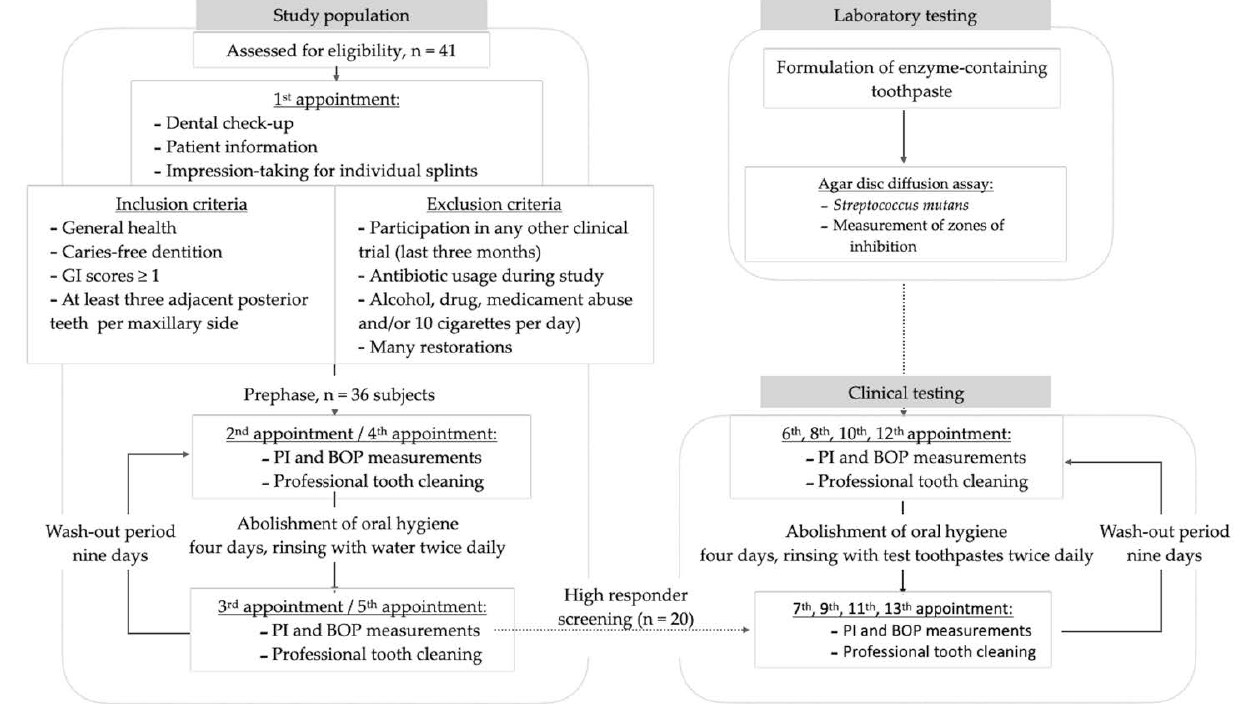
Figure 2. Flow chart with details on subject enrollment and intervention in this study. Section 2.2 (Section 2.2.1 & Section 2.2.2) Study